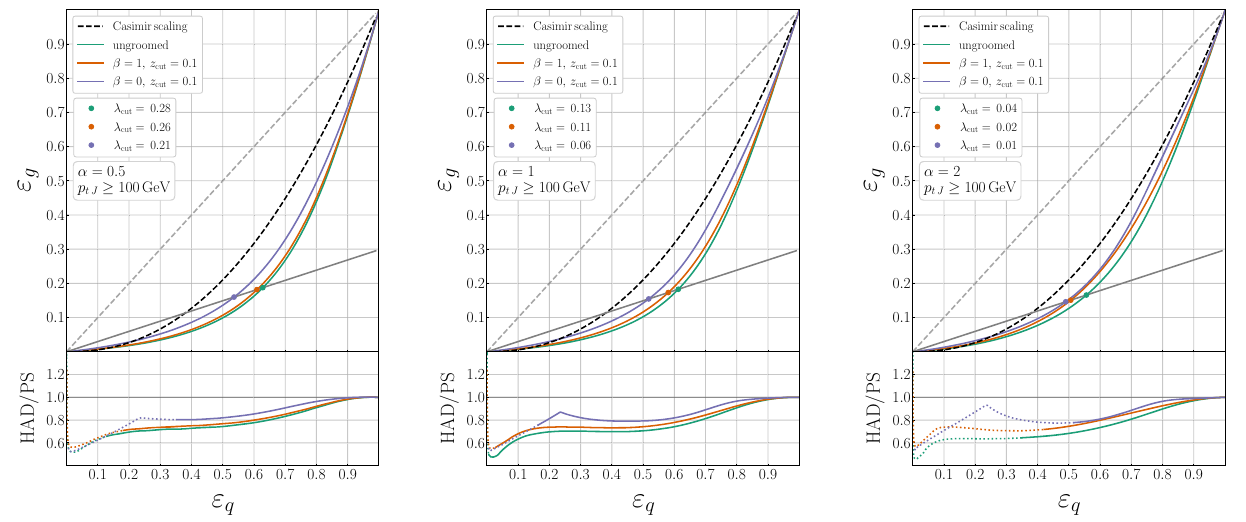
Fig. 1 Receiver Operating Characteristic (ROC) curves for different values of the angularity exponent α = 0 . 5 , 1 , 2, from left to right obtained with MC simulation using PYTHIA. In each plot, different curves refer to ungroomed jets and SoftDrop jets with z cut = 0 . 1 and β = 0 , 1. For comparison we also show the ROC curves corresponding to a random classifier (dashed grey) and the CS ones (dashed black). Straight lines represent the target performance, as detailed in the text.